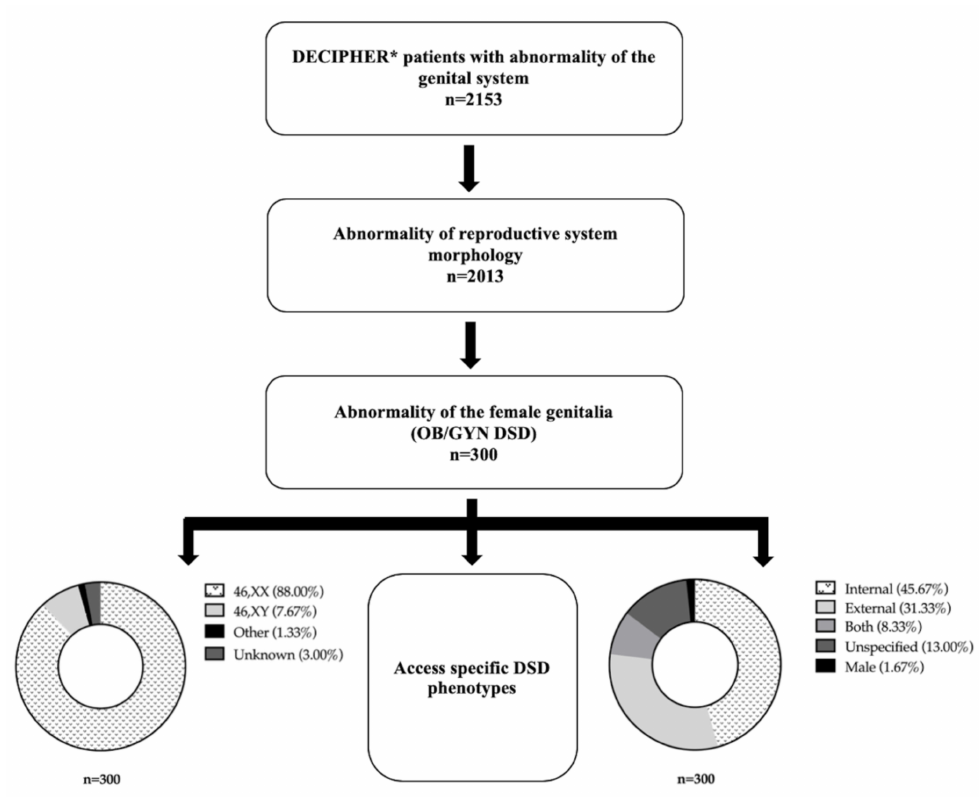
Figure 1. Methodology for identifying and categorizing patients with atypical female